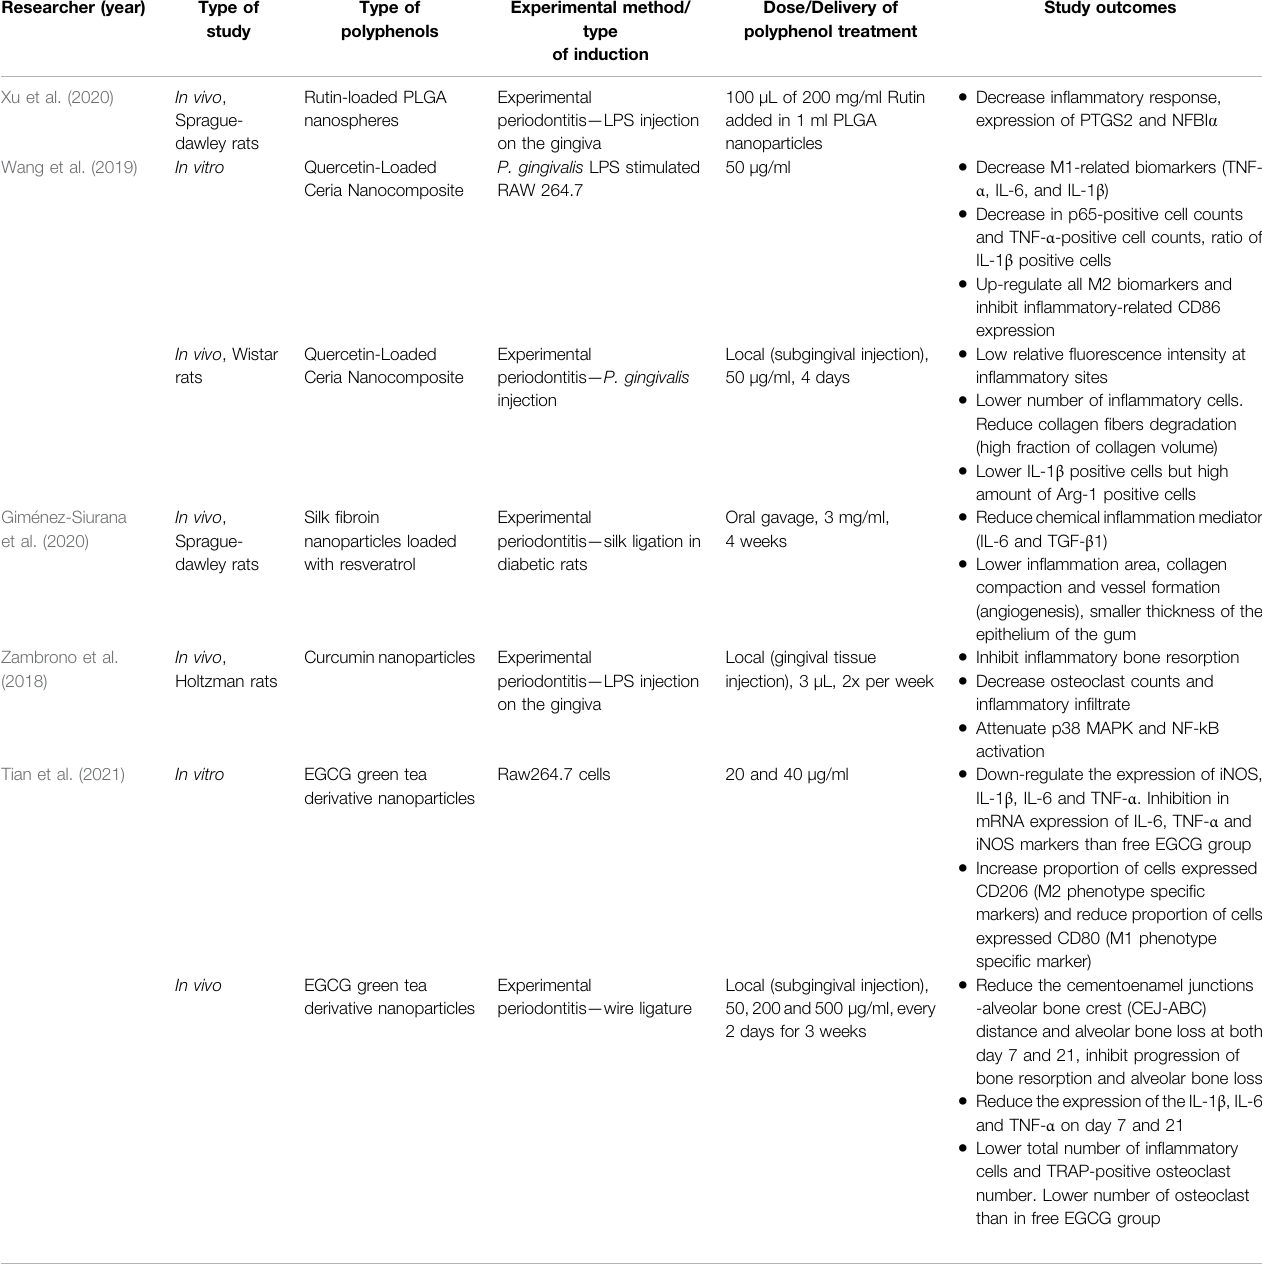
TABLE 5 | In vivo and in vitro effects of nanopolyphenols/nanoencapsulated